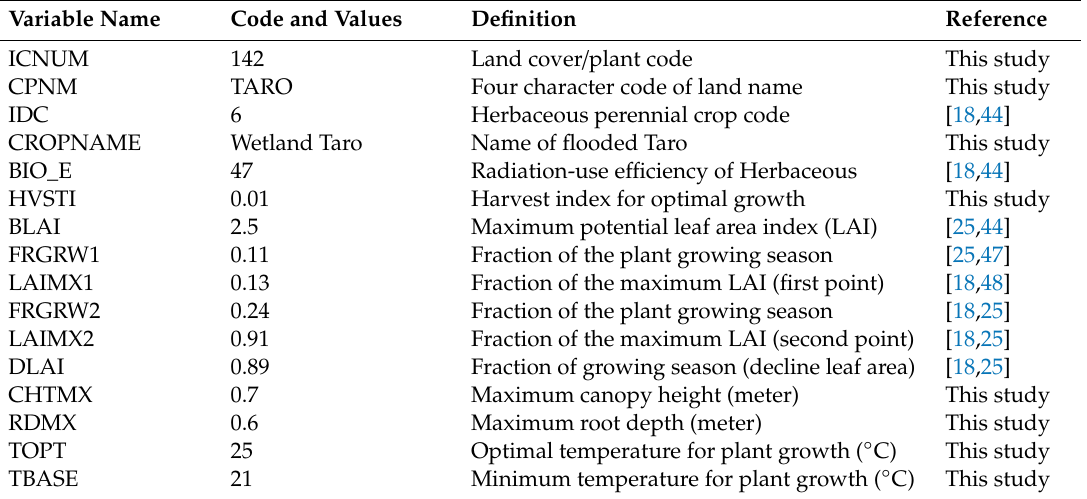
Table 1. Brief description of the variables in the Soil and Water Assessment Tool (SWAT) plant growth database file of wetland